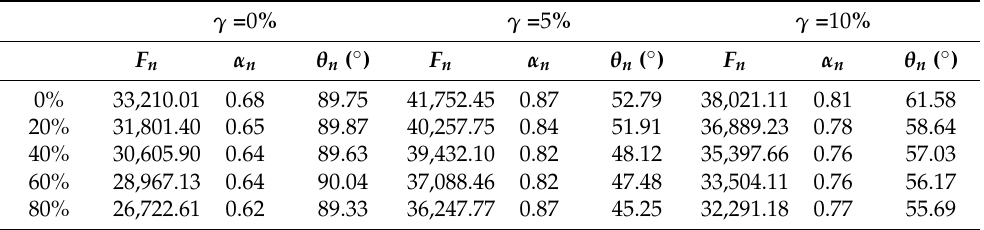
Table 3. Parameters of the normal contact force anisotropy of samples with different RCA